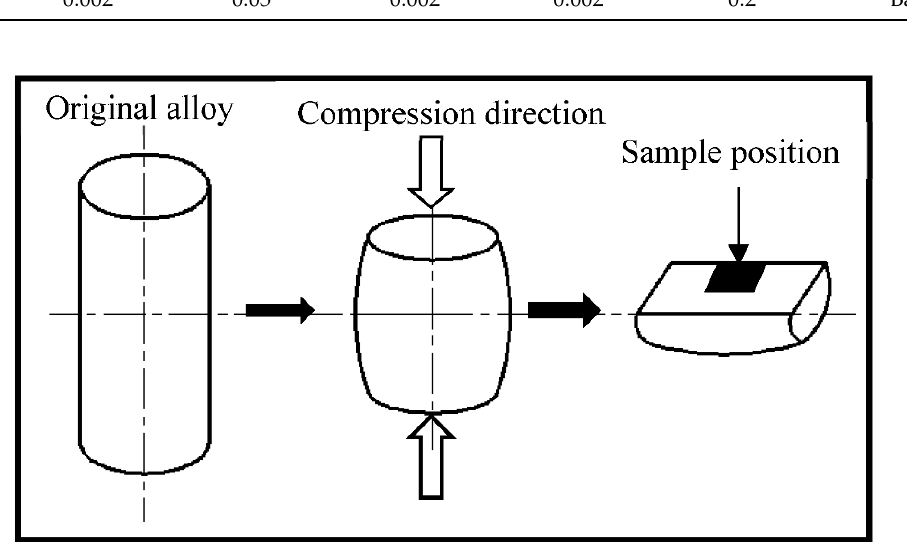
Figure 1. The schematic of thermal compression sampling.